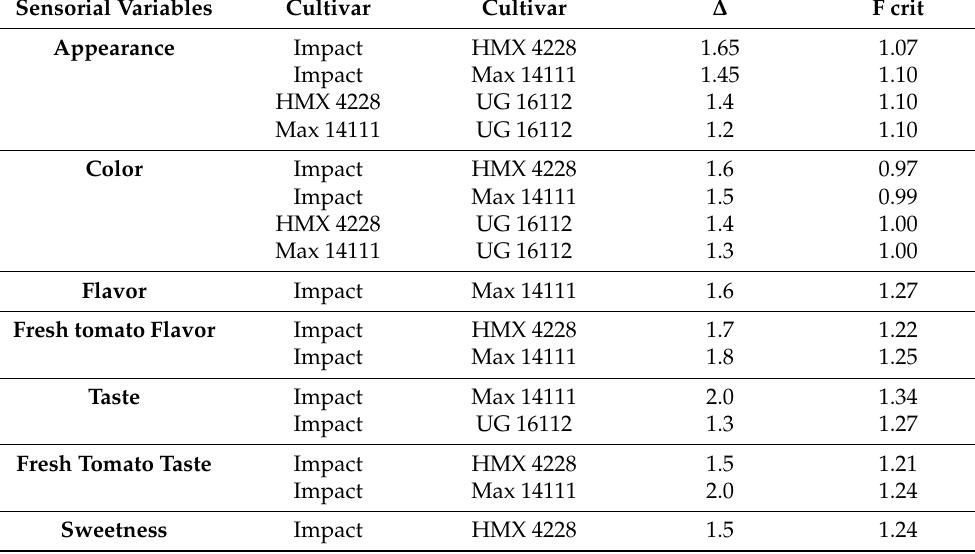
Table 7. Analysis of variance and F significance of the organoleptic features of diced tomato produced by four hybrids, referred to the variables which showed statistically significant